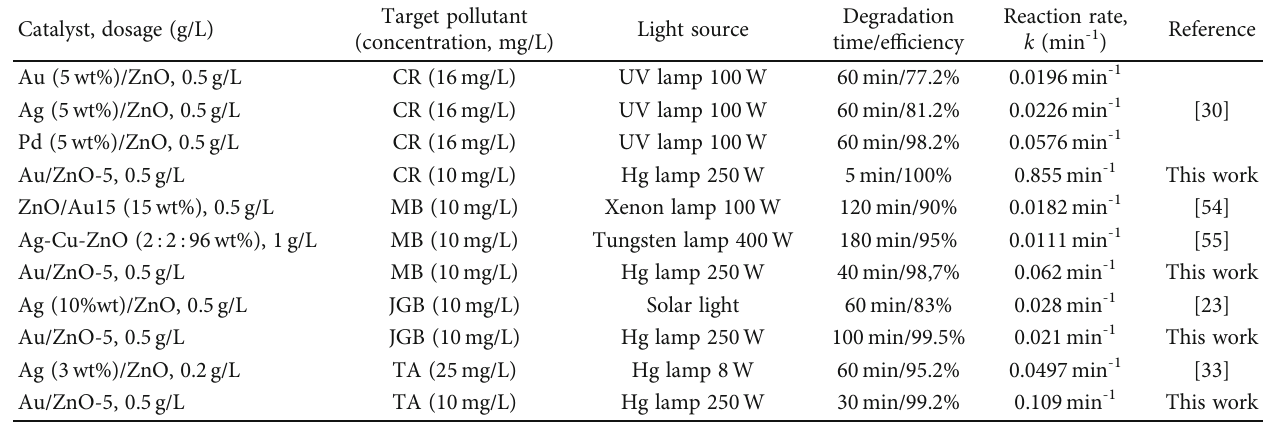
Table 1: Comparison of photocatalytic degradation of di ff erent organic dyes using precious metal-doped ZnO nanocomposites. Catalyst, dosage (g/L)